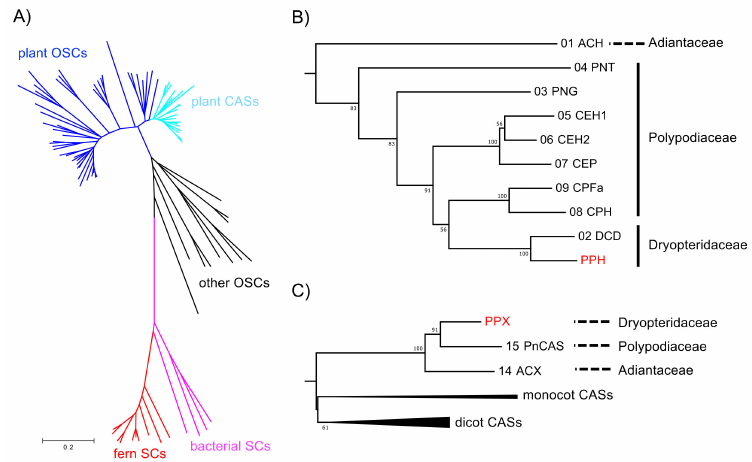
Figure 4. Phylogenetic analysis of PPH and PPX. ( A ) Unrooted neighbor-joining phylogenetic tree of OSC and SC homologs. Plant OSC and CAS clades are in blue and pale blue, respectively. Fern and bacterial SC clades are in red and magenta, respectively. For clarity, the branches have no taxon labels. The tree showing all taxon names is presented in Supplementary Figure S1. The scale represents 0.1 amino acid substitution per site. ( B ) Expanded fern SC clade from the phylogenetic tree in ( A ). Bootstrap values with 1000 replicates are shown at the nodal branches (cutoff value = 50%). The enzyme function and